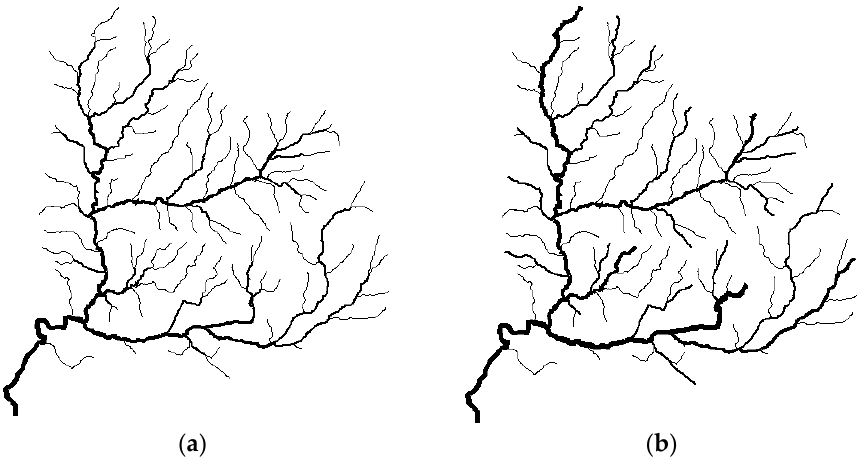
Figure 7. Tested river network for dendritic case. ( a ) is the dendritic network schemed by Horton-Strahler order. ( b ) is the network with Horton-Strahler order after upstream routine. The bolder the river tributary, the greater the Horton-Strahler order.